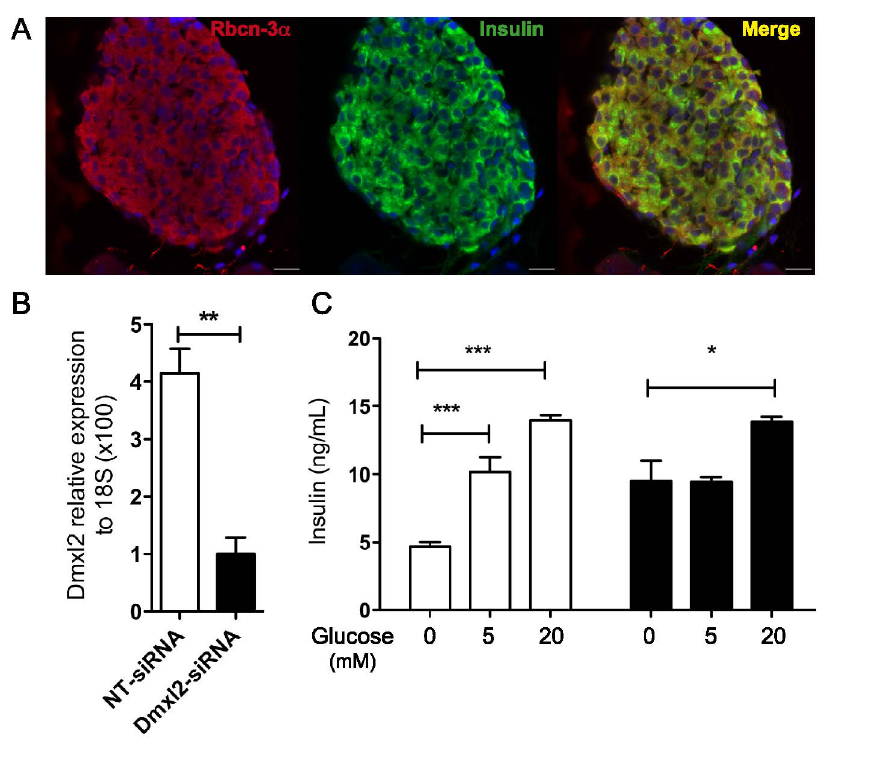
Figure 7. Dmxl2 knockdown in INS-1E cells decreases glucose-induced insulin release. (A) Rbcn-3 a is expressed in insulin-secreting cells in the islets of Langerhans in the mouse pancreas. (B) Seventy-two hours after the transfection of INS-1E cells with Dmxl2- siRNA, Dmxl2 mRNA levels had decreased by 75% (error bars: SEM; from three independent experiments). (C) Seventy-two hours after siRNA transfection, the release of insulin was evaluated by quantifying insulin concentrations in cell supernatants. In the absence of glucose, insulin concentrations in Dmxl2 -siRNA–transfected cells were double those in cells transfected with NT siRNA (NT-siRNA). In the presence of various concentrations of glucose (5 and 20 mM), Dmxl2 - siRNA–transfected cells displayed only a small increase in insulin release, at a glucose concentration of 20 mM only, whereas a 2- to 3-fold increase was observed with NT siRNA-transfected cells. Error bars: SEM from one representative experiment performed twice, in hextuplicate. * p , 0.05, ** p , 0.001, *** p , 0.0001. Numerical data used to generate graphs 7B and 7C may be found in Table